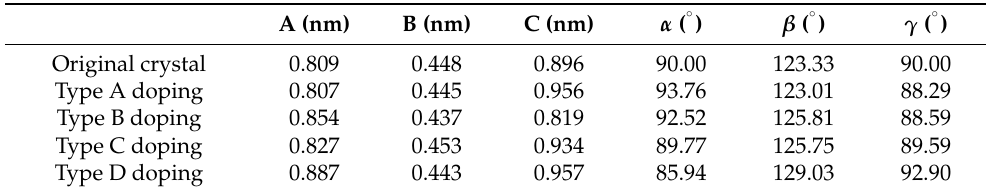
Table 1. Lattice constants after different types of